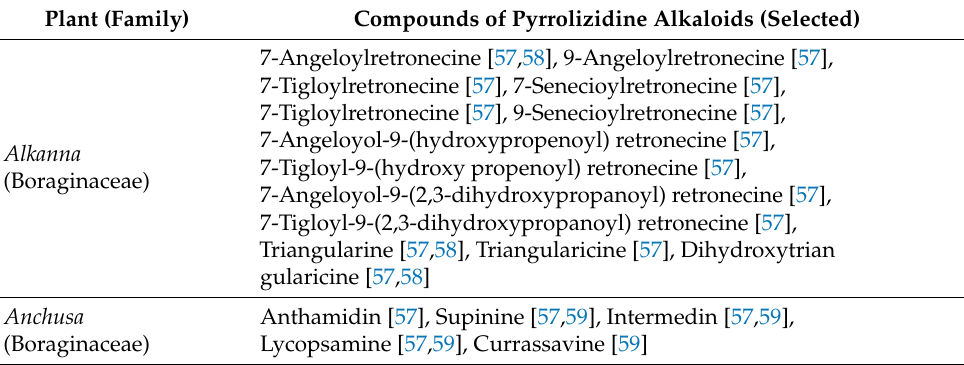
Table 3. Examples of medicinal plants containing variable PA compounds. Plant